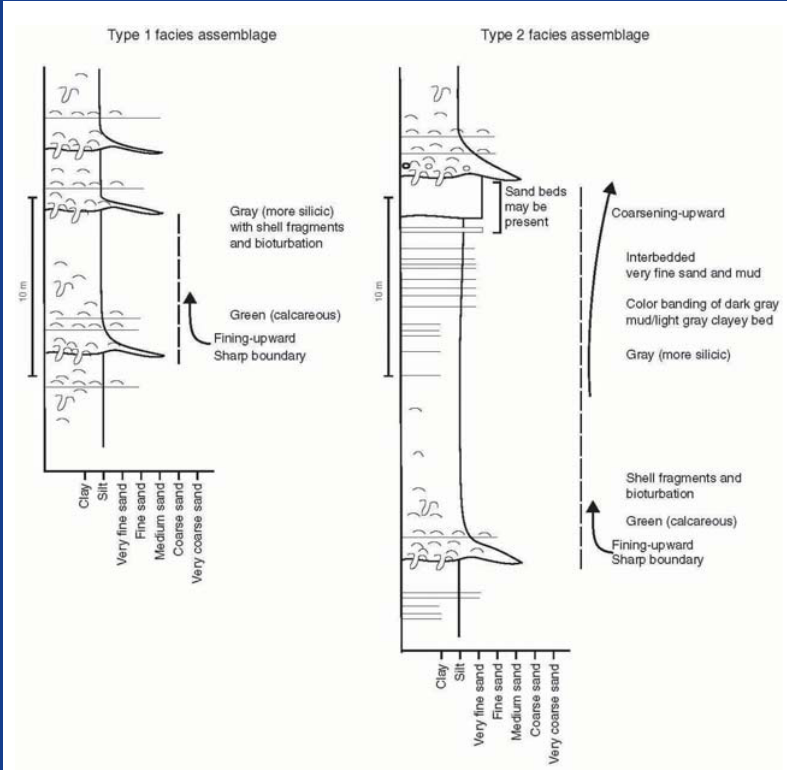
Figure 9. Schematic model of the repetitive facies assemblages that characterize lithologic Unit I. The Type 2 facies assemblage is composed of greenish-gray shelly bioturbated mud with a sharp lower contact (ravinement surface), followed by a transition uphole into dark gray micaceous very fine sandy mud with color banding and alternations of sand and mud showing upward coarsening. The Type 1 facies assemblage is the basal part of the Type 2 assemblage (from Fulthorpe et al.,